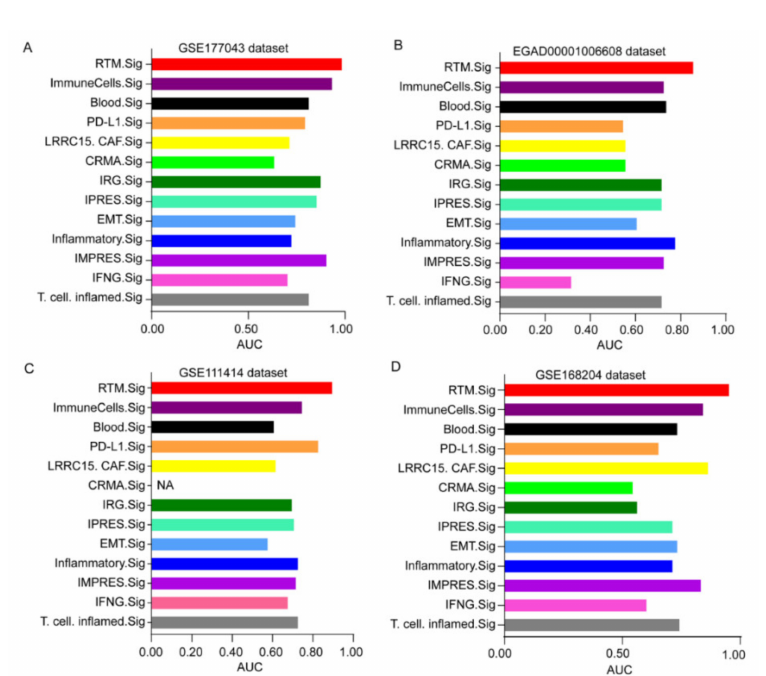
Figure 7. Comparing the predictive performance of RTM.Sig with previous gene signatures. Multiple bar plots showing the AUC values of 13 ICT response signatures in the GSE177043 dataset ( A ), in the EGAD00001006608 dataset ( B ), in the GSE111414 dataset ( C ) and in the GSE168204 dataset ( D ). NA (not available) means this gene signature was not found in corresponding